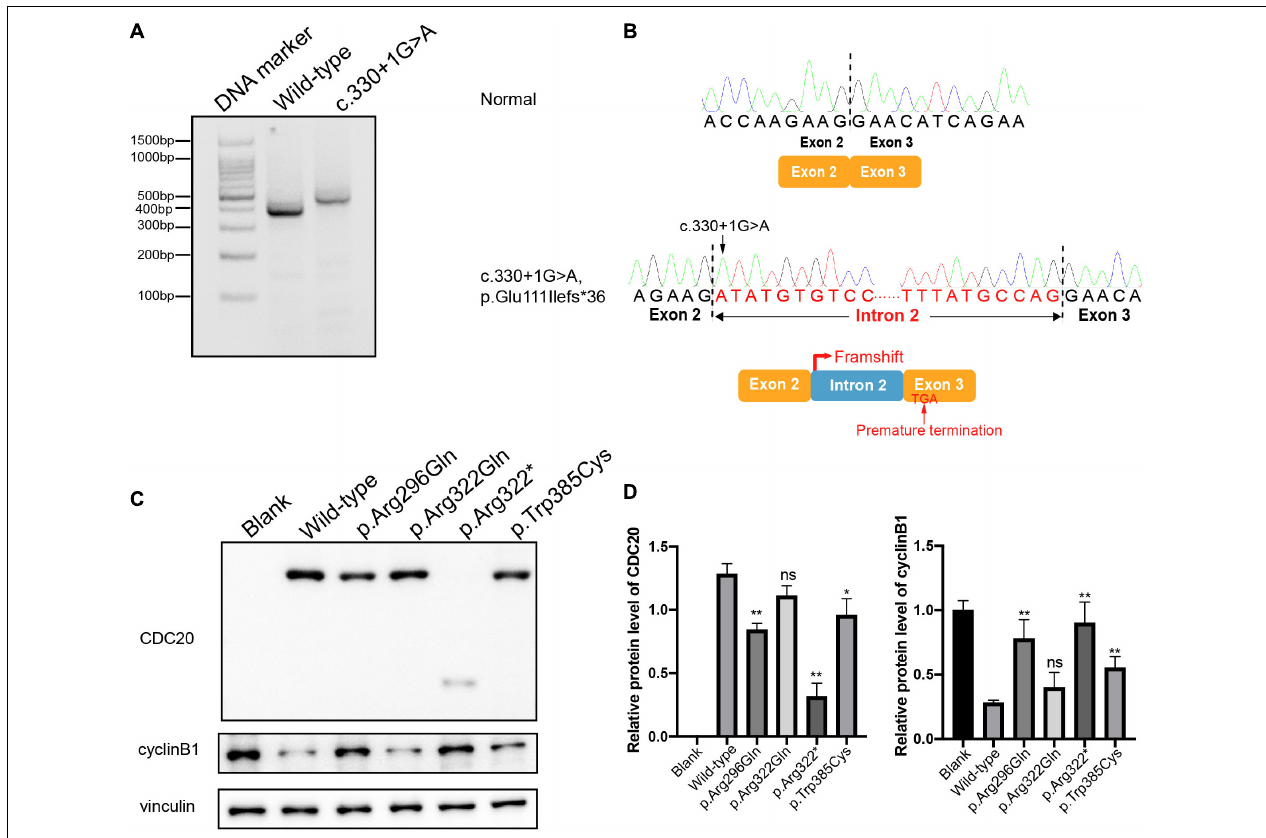
FIGURE 3 | Effects of the mutations on CDC20 transcript, CDC20 and cyclin B1 protein levels. (A) Agarose gel electrophoresis illustrating the effect of the CDC20 c.330 + 1G > A mutation. Compared with the wild-type lane, the c.330 + 1G > A lane showed a larger size band. (B) The CDC20 c.330 + 1G > A splicing mutation missed the canonical donor splice site, resulting in retention of intron 2 and the premature termination of the CDC20 protein. (C) The effects of the mutations on CDC20 and cyclin B1 protein level by western blotting in CHO cells transfected with wild type or mutant vectors. (D) Quantification of wild type and mutant CDC20 protein levels and cyclin B1 protein levels in CHO cells. Quantification was performed by measuring the band intensity of CDC20 and cyclin B1 relative to that of vinculin. The data are shown as means and SEM. * p < 0.05, ** p < 0.01, ns, not significant.